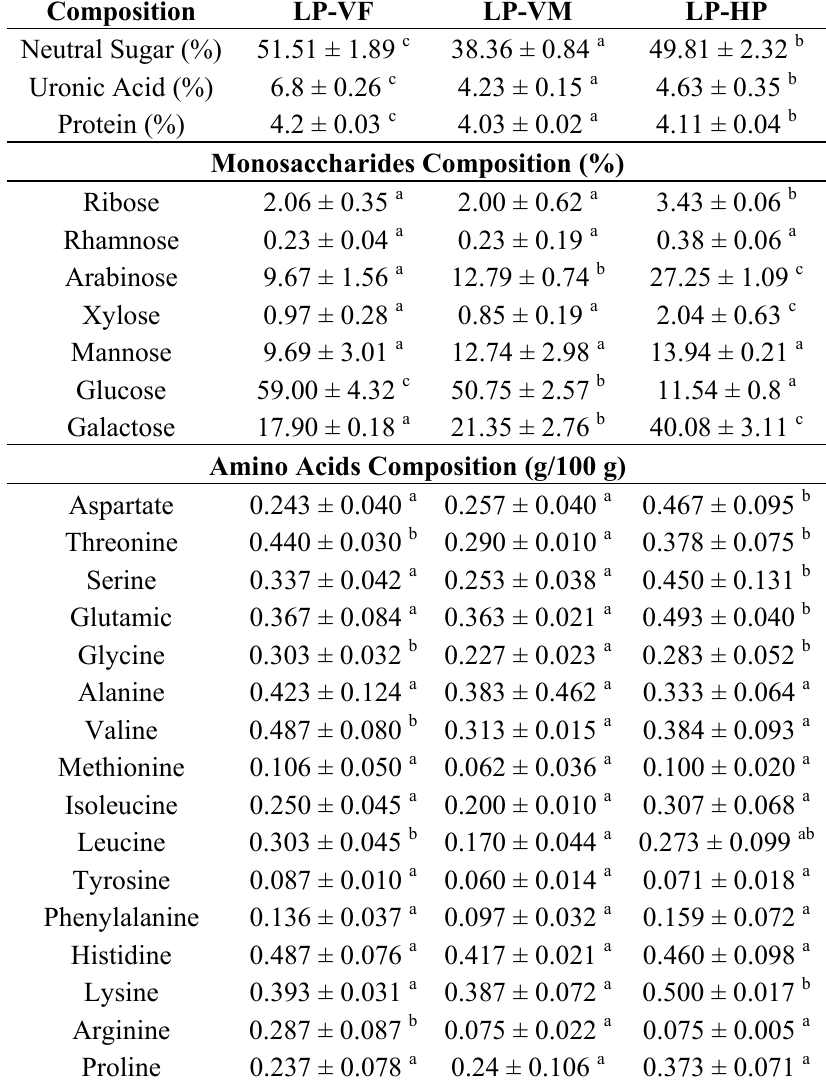
Table 1. Chemical compositions of litchi polysaccharide-protein